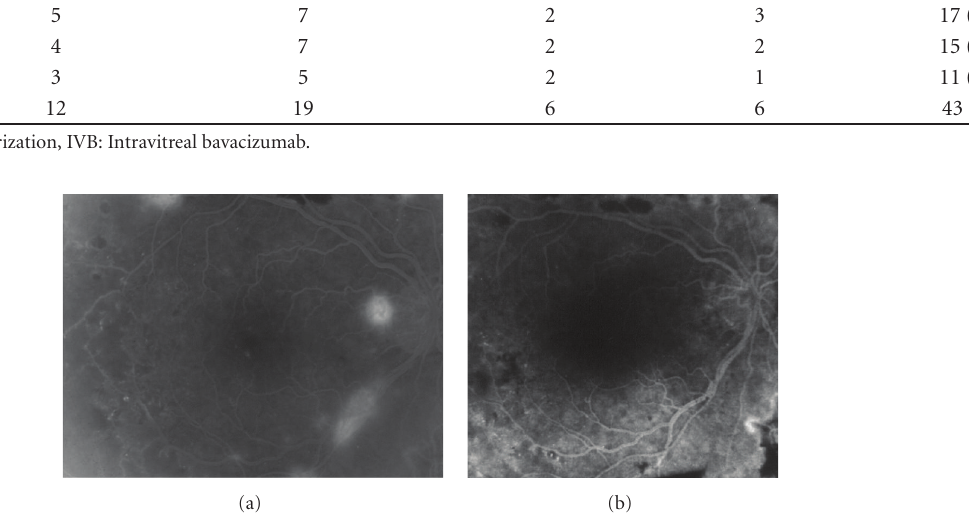
Table 1: Regression of RN on fundus examination with absence of fluorescein leakage after IVB at 24 months ∗ . RN Regression